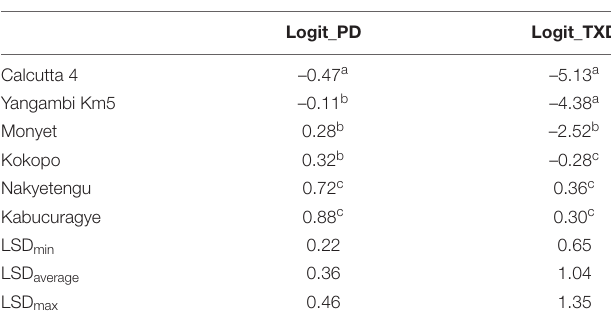
TABLE 1 | The least significant difference (LSD) comparison between the adjusted means for logit-transformed PD (logit_PD) and TXD (logit_TXD) for the checks and the parents of the